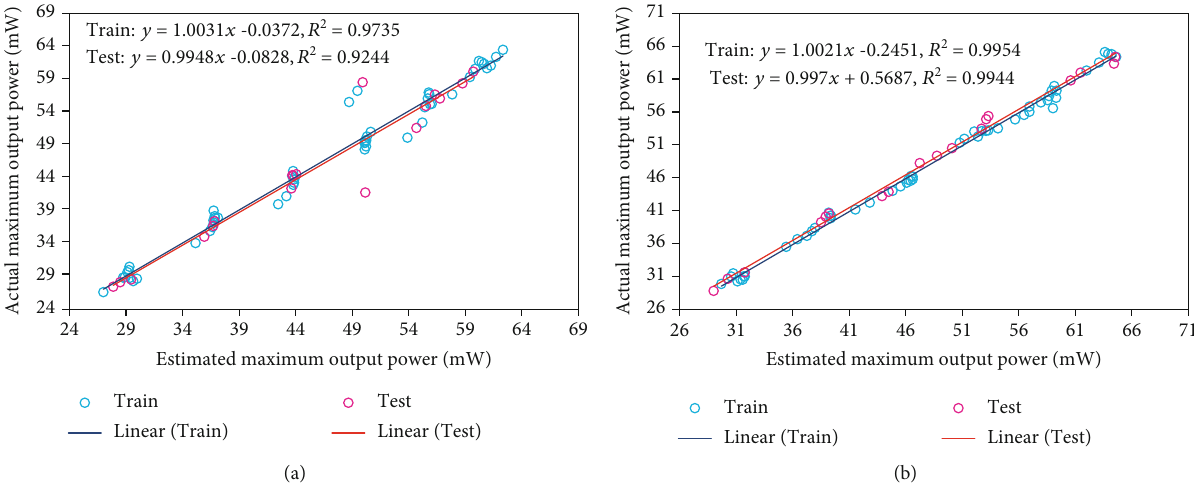
Train: y = 1.0031 x -0.0372, R 2 = 0.9735 Test: y = 0.9948 x -0.0828, R 2 = 0.9244